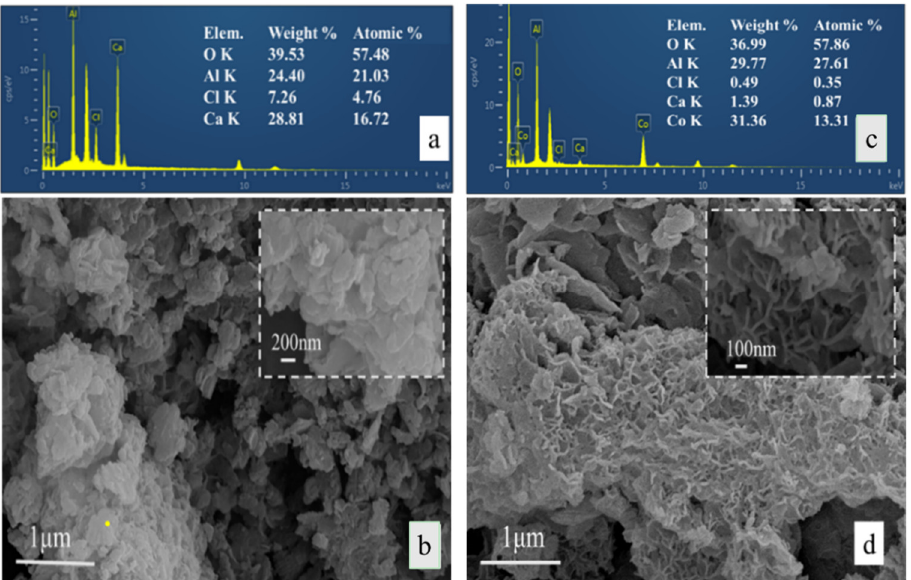
Figure 3. The energy dispersive X‐ray spectroscopy (EDS) spectrum and SEM images of CaAl‐Cl‐LDH ( a , b ) and Co‐LDH ( c , d ).